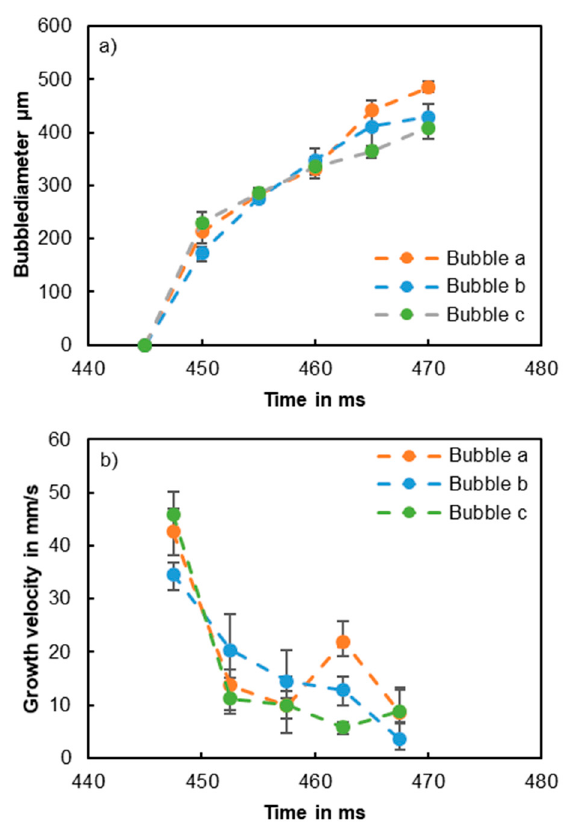
Figure 4. Average diameter, ( a ), and average growth velocity, ( b ), of bubbles “a”, “b”, and “c” during welding in overlap configuration of uncleaned AA6016 sheets with a feed rate of 12 m / min, a beam diameter of about 500 µ m, and a laser power of 8.5 kW.